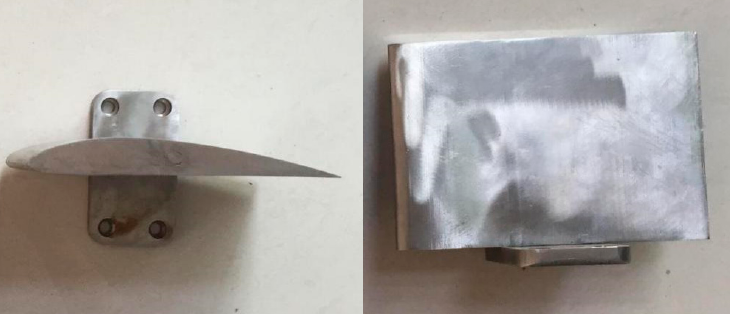
Figure 3. Hydrofoil physical model.